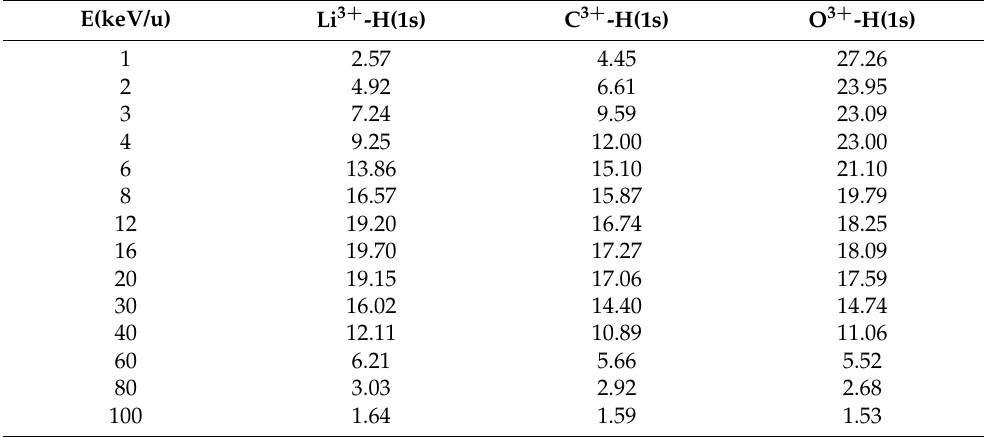
Table A2. Total capture cross sections (10 − 16 cm 2 ) for Li 3 + , C 3 + , and O 3 + collisions with ground-state hydrogen from 1 to 100